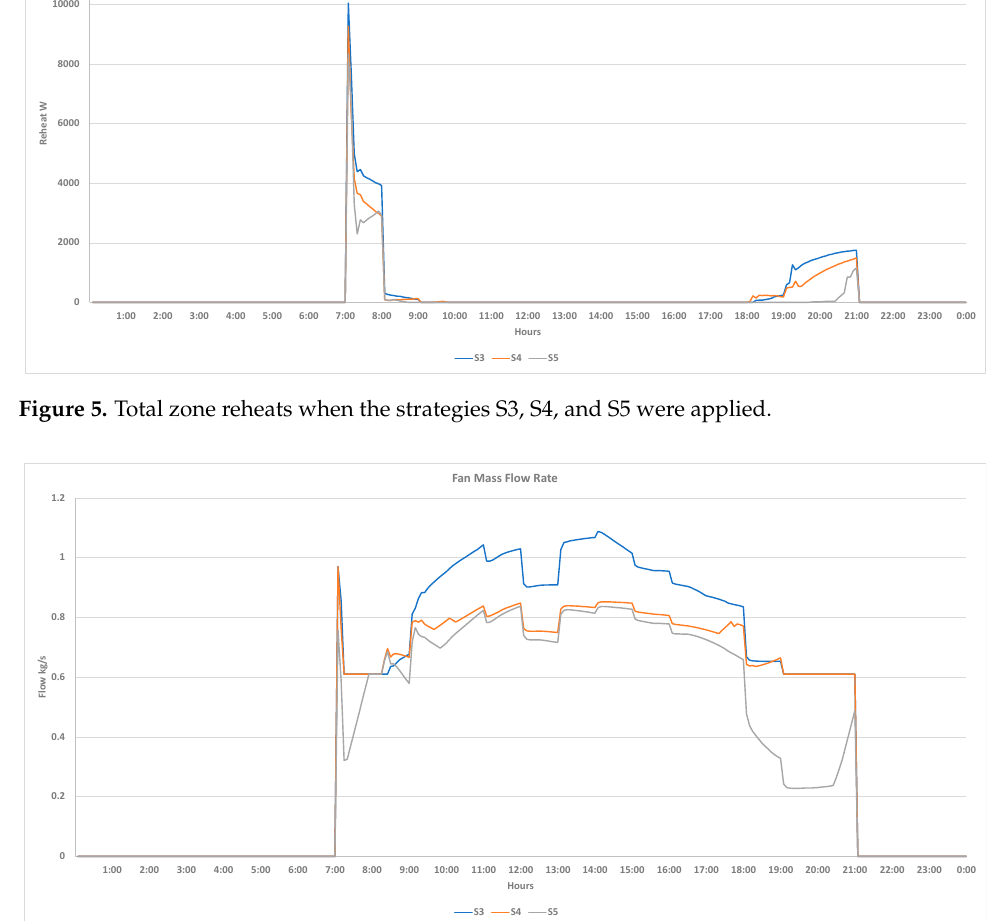
Figure 6. Fan mass flow rates when the strategies S3, S4, and S5 were applied.